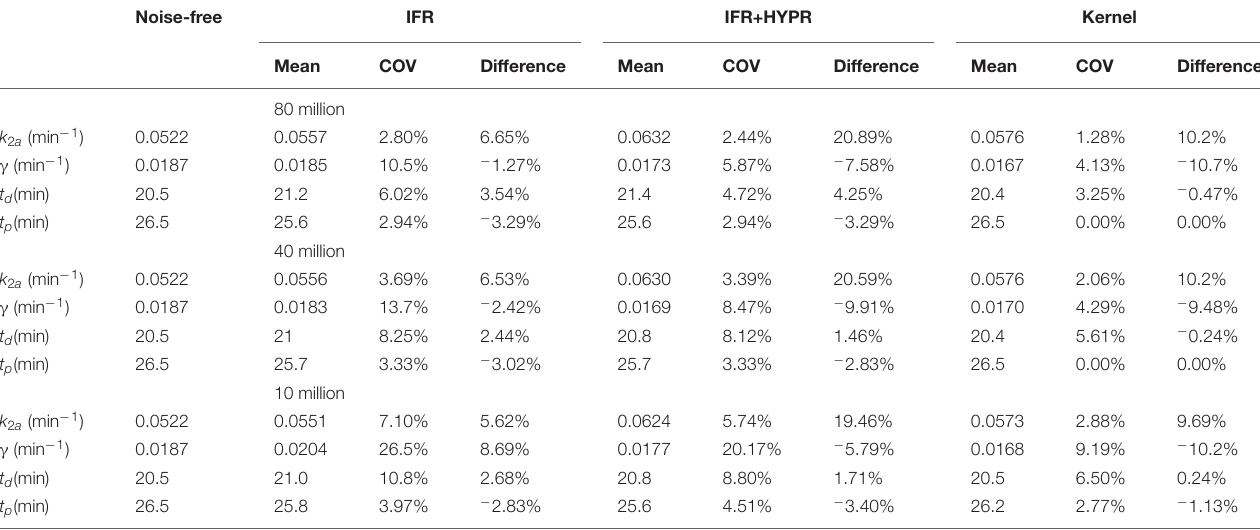
TABLE 1 | Regional lp-ntPET kinetic modeling k 2 a , γ , t d and t p mean, coefficient of variation (COV), and difference with respect to noise-free value, for independent frame reconstruction (IFR), independent frame reconstruction with HYPR denoising (IFR+HYPR), and spatiotemporal kernel reconstructions (Kernel), in simulations with 80, 40 and 10 million counts.